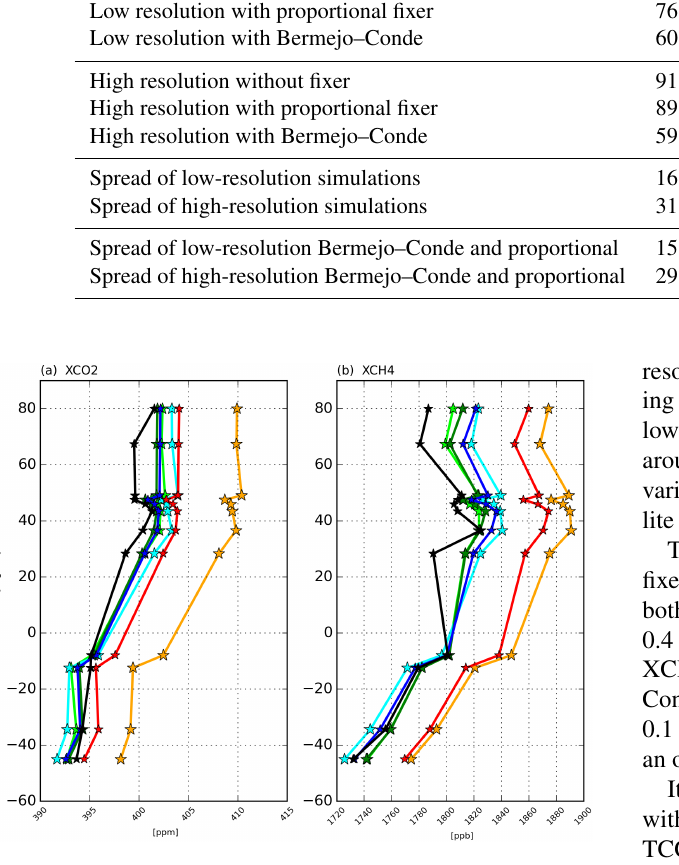
Figure 8. Comparisons of latitudinal distribution of (a) XCO 2 and (b) XCH 4 as derived from monthly mean (7 March to 10 April) TCCON sites (black, see Table 2) and simulations using different mass fixers at different resolutions: red and orange without mass fixer at low and high resolutions respectively; blue and cyan with the proportional mass fixer at low and high resolutions respectively; and green and light green with the Bermejo–Conde fixer and low and high resolutions respectively. See Table 1 for a more detailed description of the